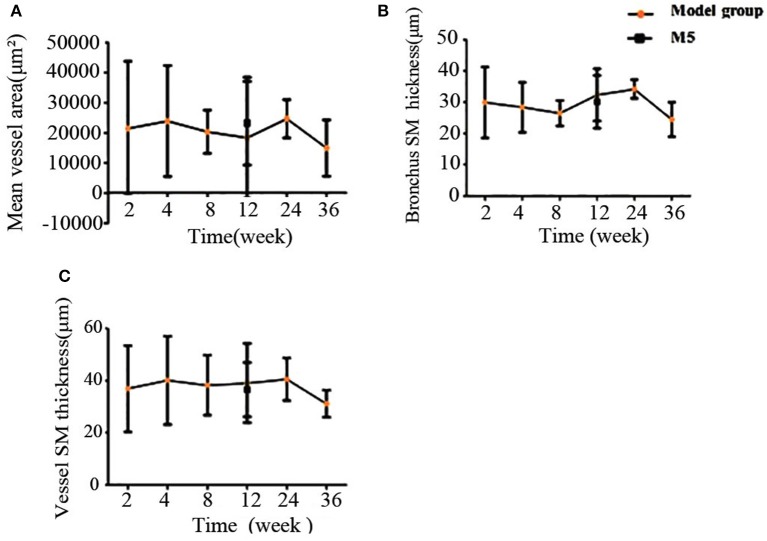
Comparison of HE-stained rat lung tissue of the model groups, based on semi-quantitative analysis. (A) Mean vessel area. (B) Bronchus smooth muscle thickness. (C) Vessel smooth muscle thickness. H&E, haematoxylin-eosin.